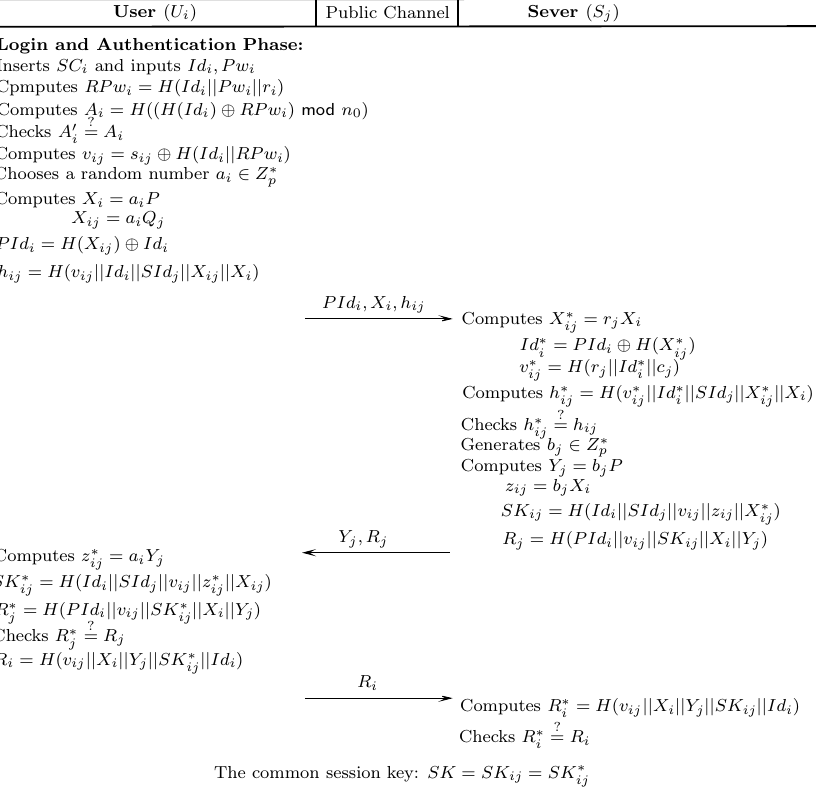
Figure 4. Login and